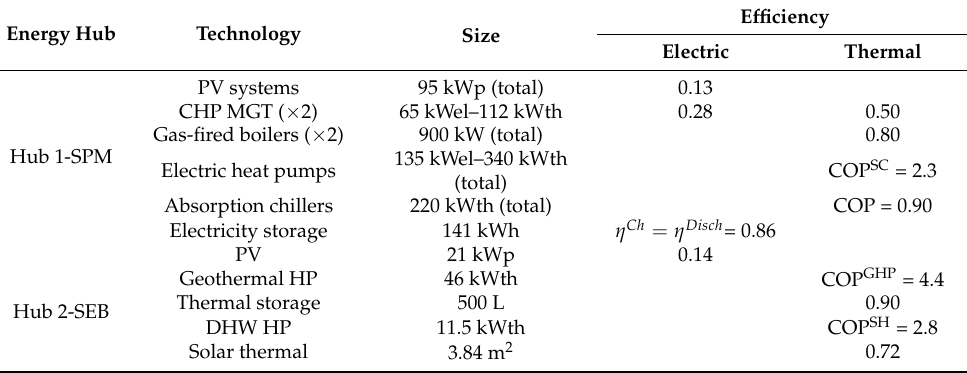
Table 1. Technical data for the technologies of the Savona